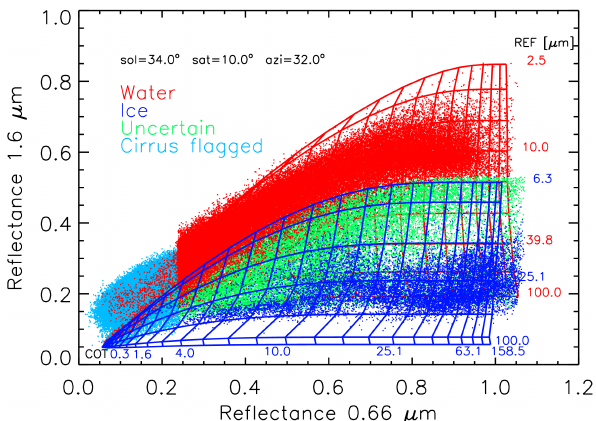
Figure 4. AATSR atmospheric corrected reflectance in the visible and near infrared (dots) for water, ice, uncertain and cirrus pixels from the scene shown in Fig. 3. The two grids represent the forward- modeled AATSR reflectances for water (red) and ice (blue) clouds, assuming mean viewing geometry and surface albedo values for the scene.